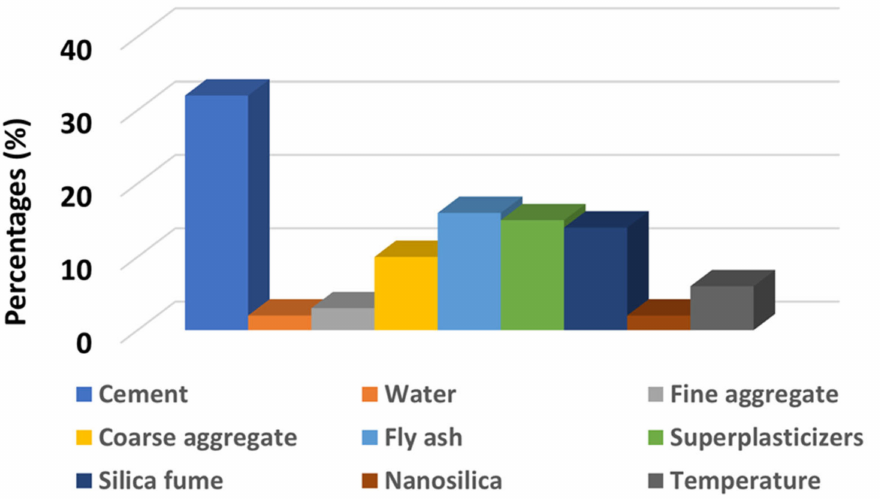
Figure 5. Bar chart indicating the performance of input parameters with regards to predicting of the compressive strength of